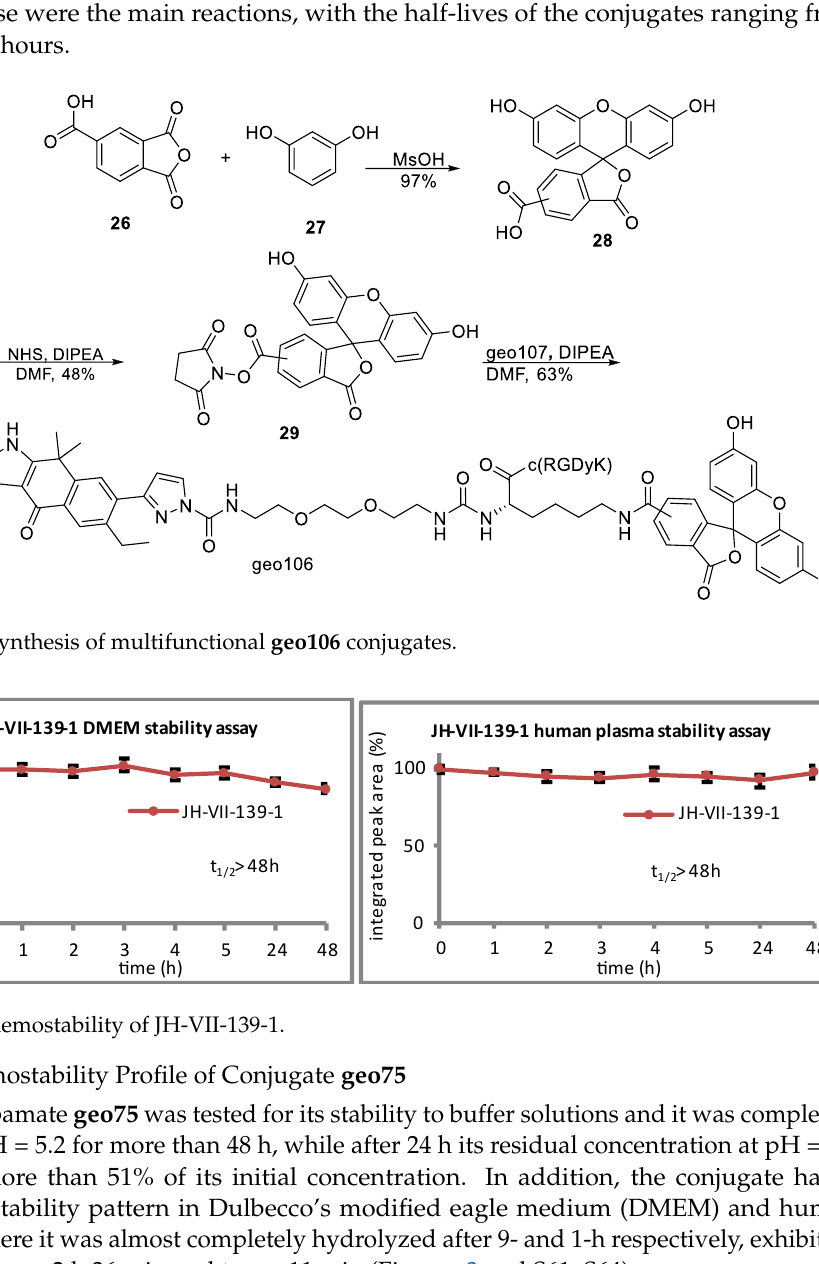
Figure 2. Chemostability of JH-VII-139-1.